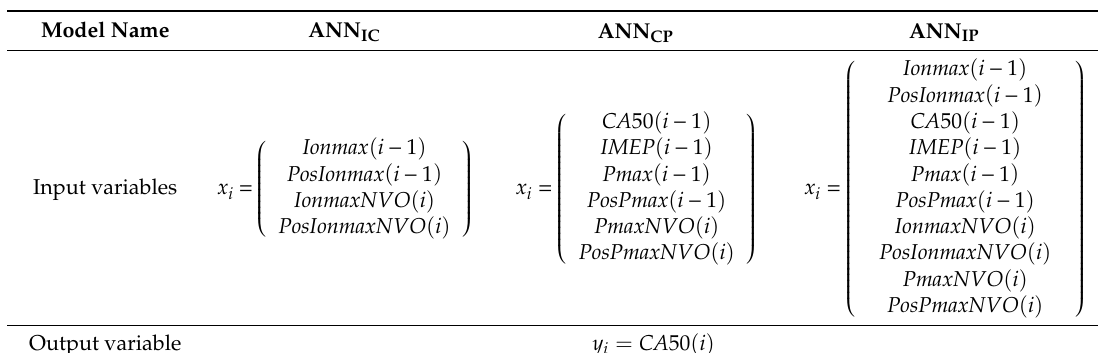
Table 3. The input and out variables of three ANN models.